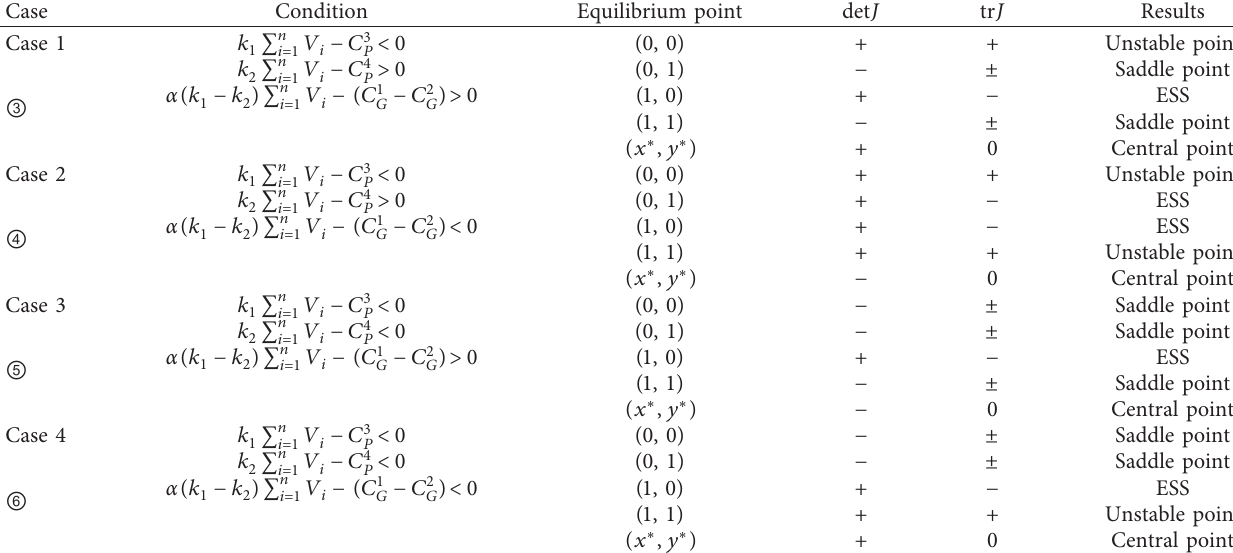
Table 6: The evolutionary stability of local equilibrium points under four